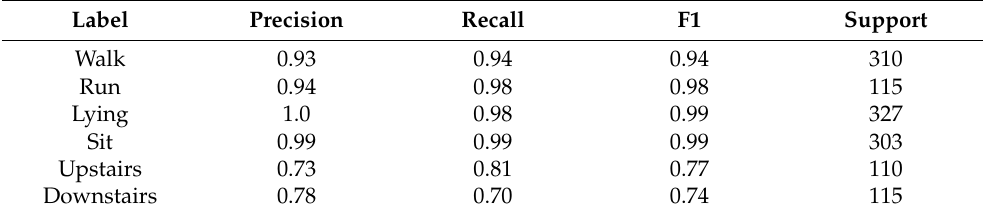
Figure 14. The confusion matrix obtained by using the MarFusion model to predict the training set. Table 4. Final evaluation indicators corresponding to various